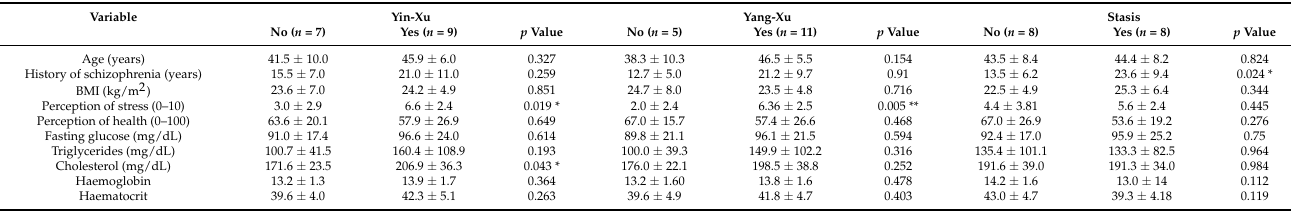
Table 2. Comparisons of participants’ characteristics and biomarkers between constitutions of Yin-Xu, Yang-Xu, and Stasis (treated with olanzapine, n = 16).